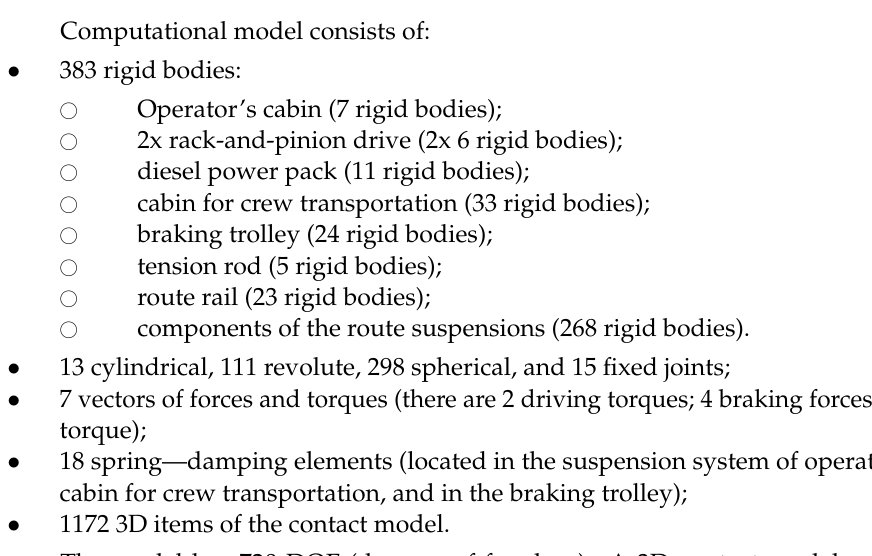
Figure 4. Computational model of a suspended monorail on the test stand [7].